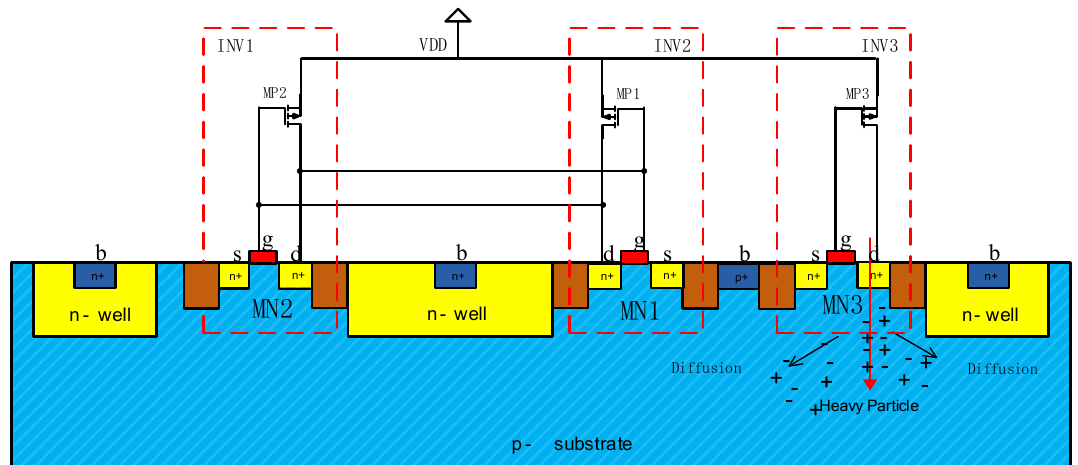
Figure 9. Drain voltages of MN1 and MN2 when the drain of MN2 is struck by a particle.